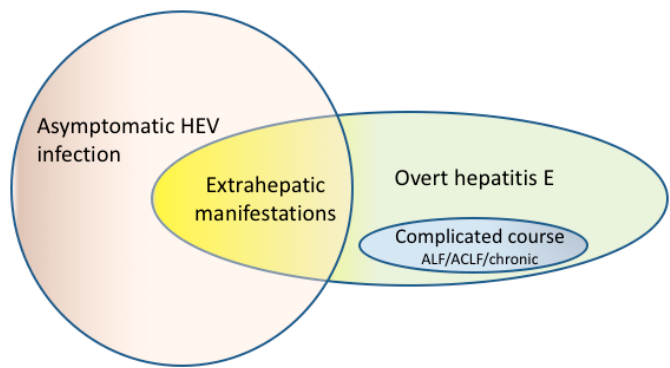
Figure 3. Schematic representation of HEV infection: In the vast majority, patients have a clinically asymptomatic course. Acute hepatitis E is generally self-limited. A minority of infected individuals develop clinically overt hepatitis E. In rare cases HEV infection can result in acute liver failure (ALF) or in acute-on-chronic liver failure (ACLF) in patients with preexisting liver disease. Chronic hepatitis E can occur in immunosuppressed